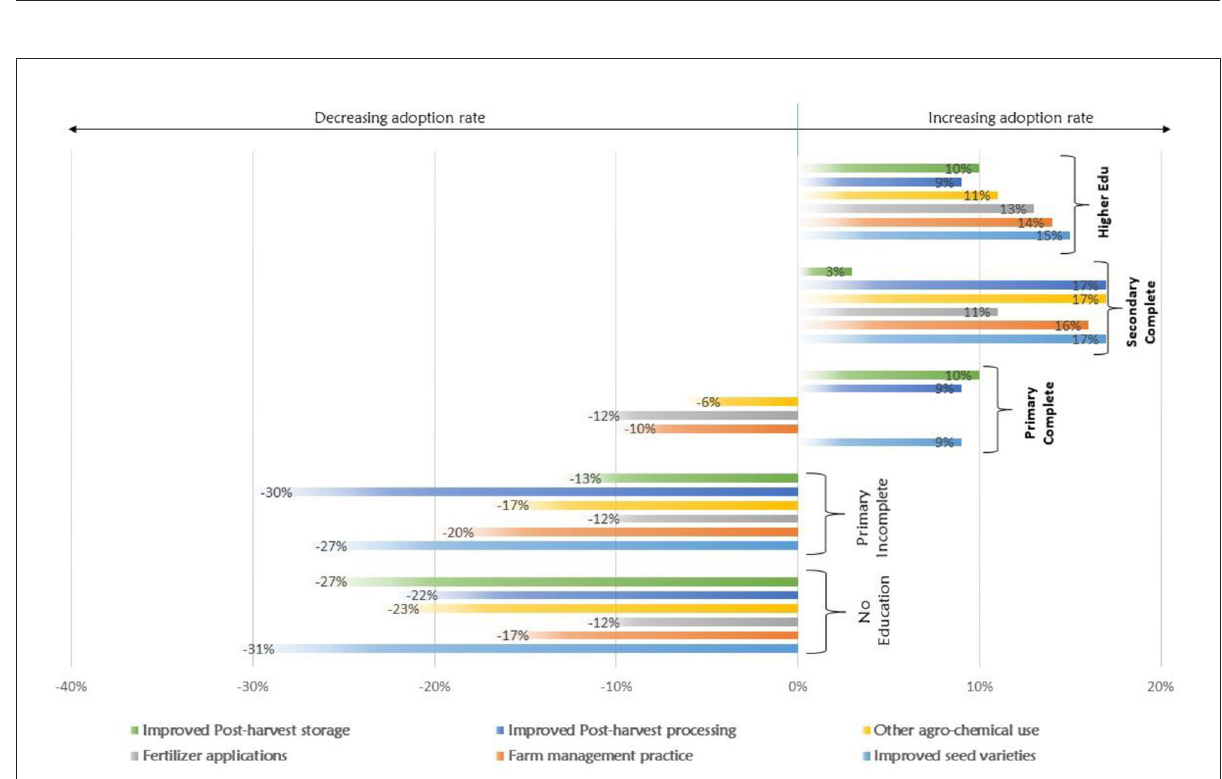
FIGURE8 Variance analysis of technology adoption per education level. Author,